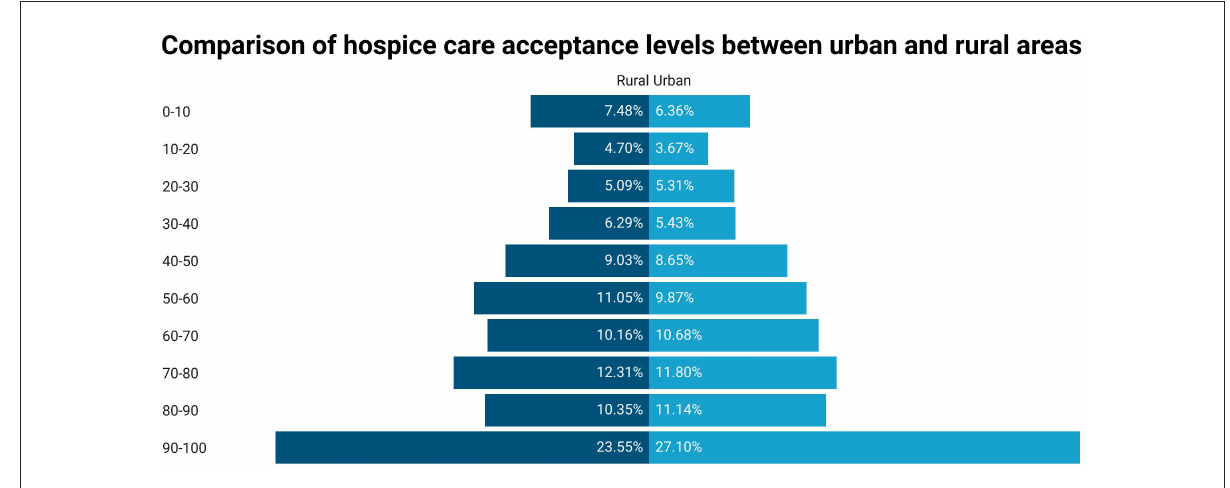
FIGURE5 Comparison of hospice care acceptance levels between urban and rural